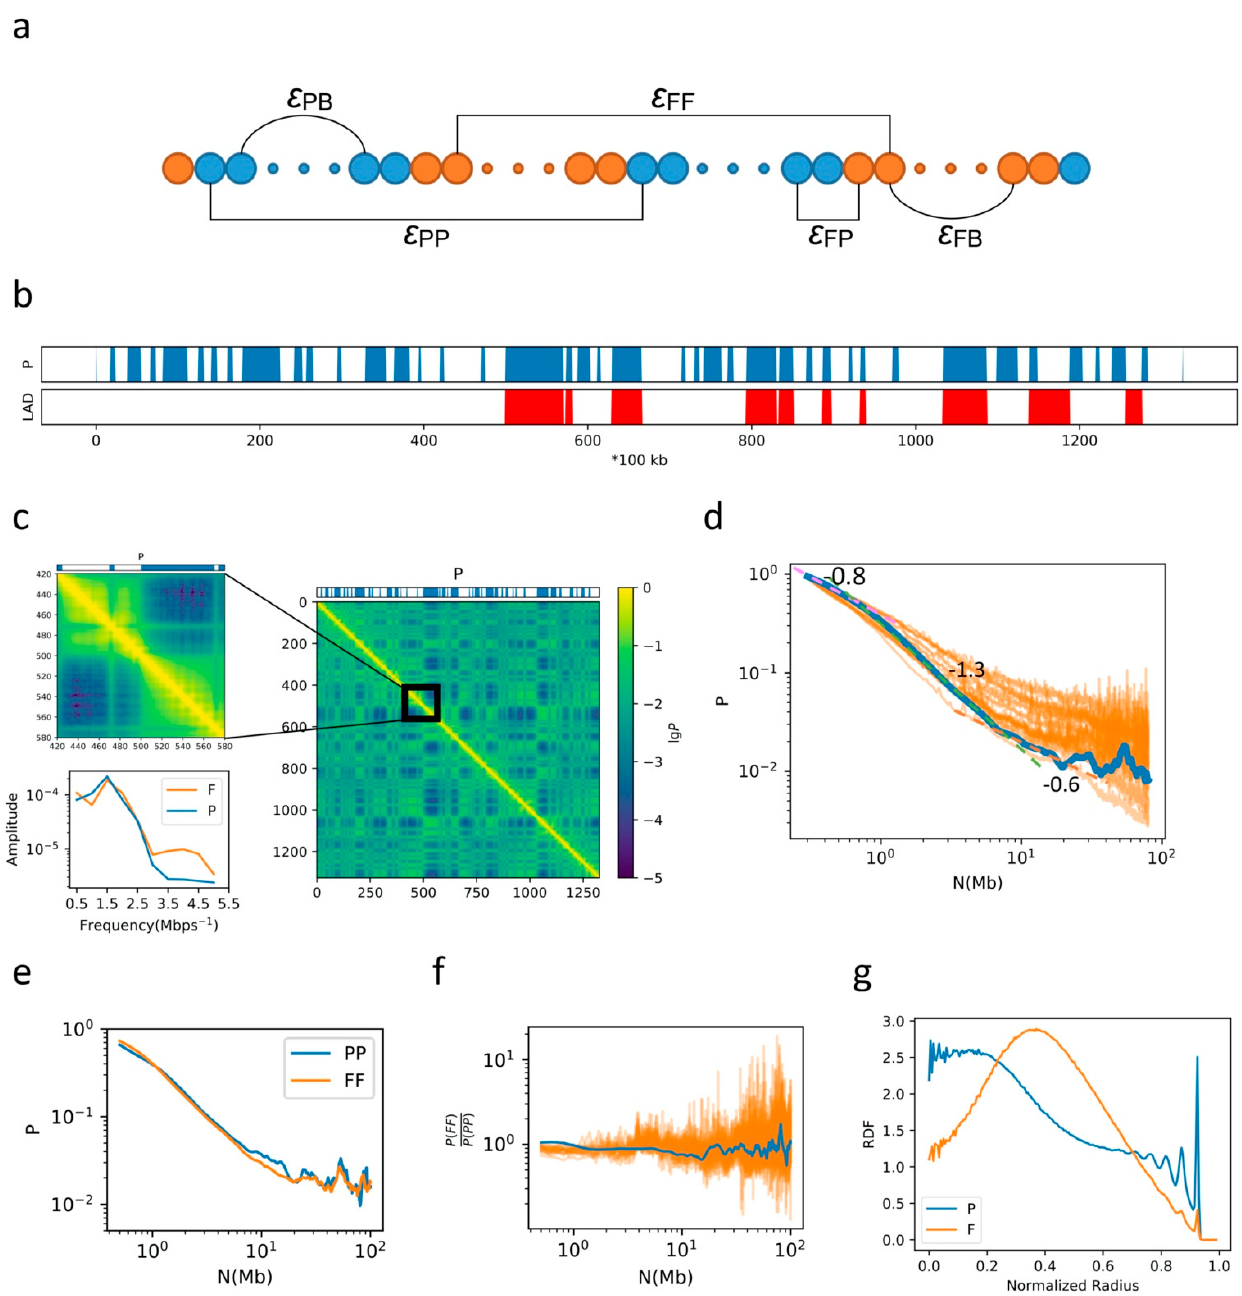
Figure 1. ( a ) A graphical illustration of the model, in which blue beads representing P domains and orange beads representing F domains; ( b ) The P-domain and lamina-associating domains (LAD) annotation of chr10; ( c ) The contact map generated from the simulation and the profile of P domains, and the lower left panal shows the results of windowed Fourier transform; ( d ) The blue plot is the contact probability as a function of sequential distance calculated from the contact map in ( c ), and the orange plots are experimental data from up to 20 cell types; ( e ) The contact probability of F and P domains as a function of sequential distance; ( f ) The ratio between the contact probability of F and P domains, with the blue line calculated from simulation results and orange lines calculated from experimental data; ( g ) The radial distribution for beads in F and P domains.